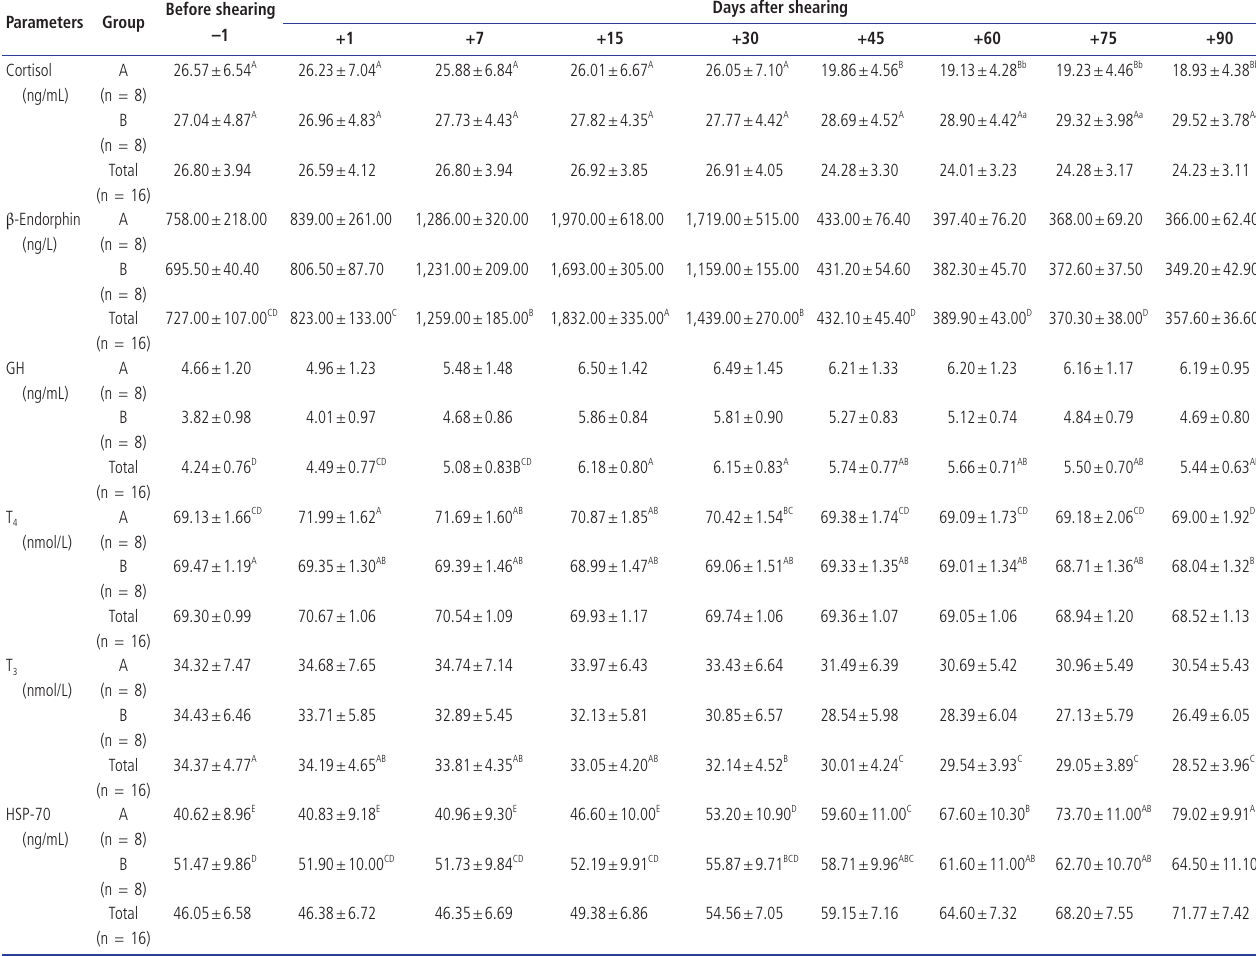
, T , and HSP-70 in the groups during the experiment 4 3